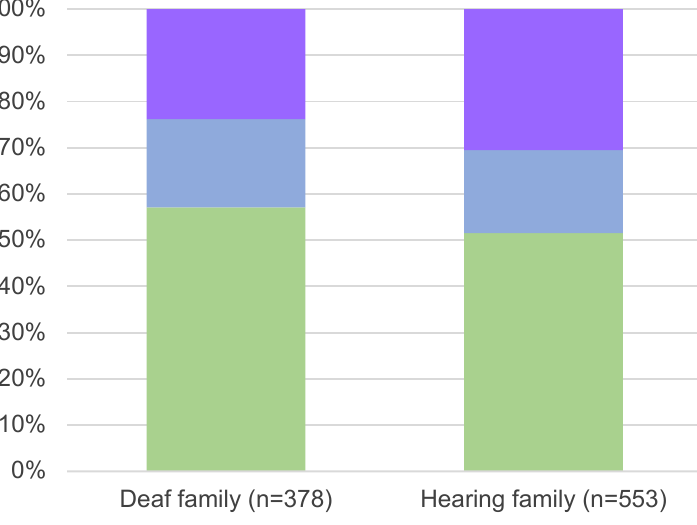
Figure 19: Distribution of fingerspelling-related tokens by nativisation category (L only) and by family language